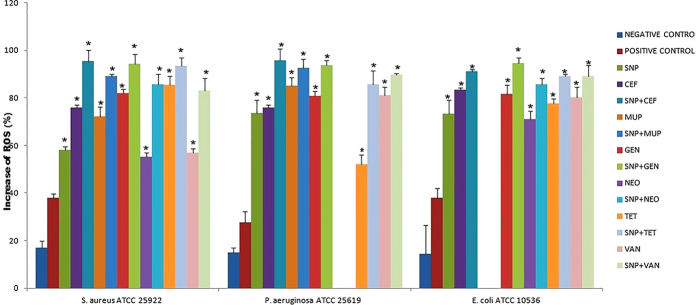
Comparative ROS formation assay.Values are expressed as means (n = 3), and error bars represent standard deviations. Asterisks (*) indicate a statistical significant difference (P < 0.05) between the negative control and the treatments.